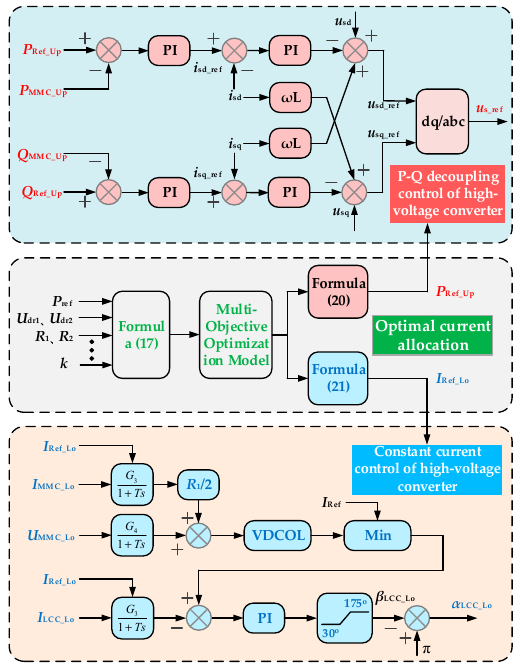
Figure 9. Improved HVDC control based on optimal current allocation.